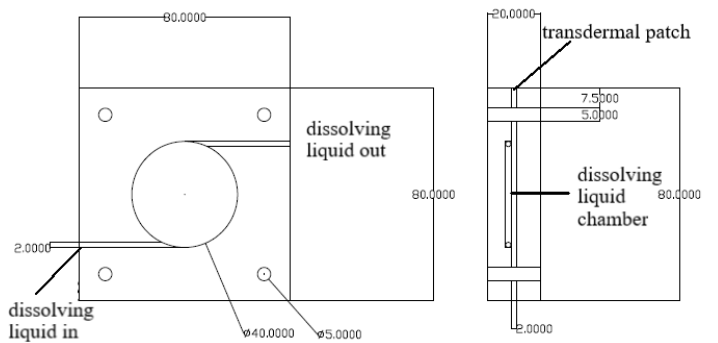
Figure 6. The flow ‐ through cell. Figure 6. The flow-through cell.